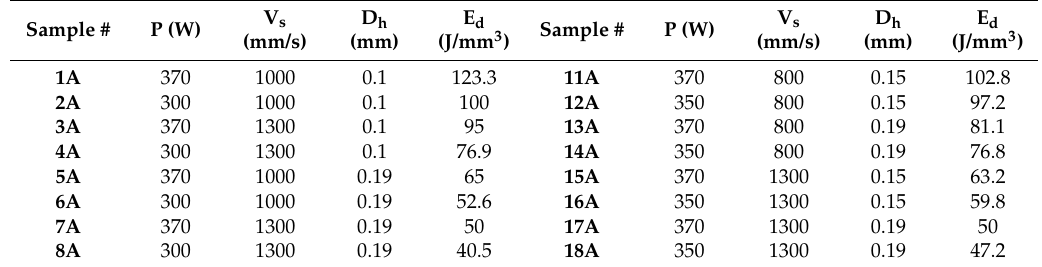
Table 2. The SLM process parameters applied for fabricating the Al6061